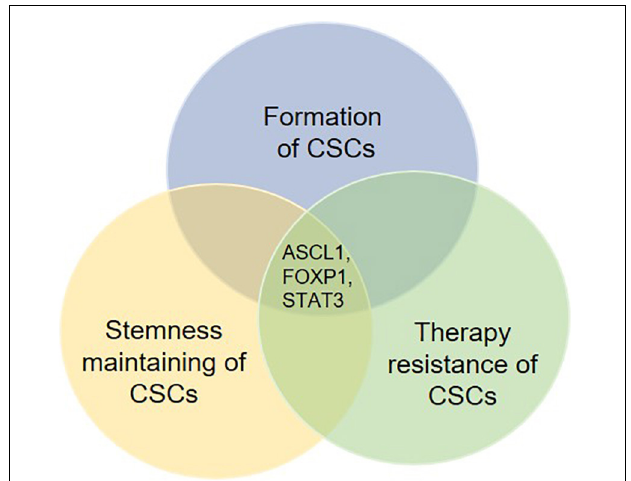
FIGURE 4 | Potential key regulatory factors governing the fate determination of CSCs. Several molecules are found to be involved in not only the formation, the stemness maintenance but also the therapy resistance of CSCs. These molecules such as ASCL1, FOXP1, and STAT3 may work as key regulatory factors for fate determination of CSCs. Therefore, therapies targeting such molecules are likely to show an effective effect